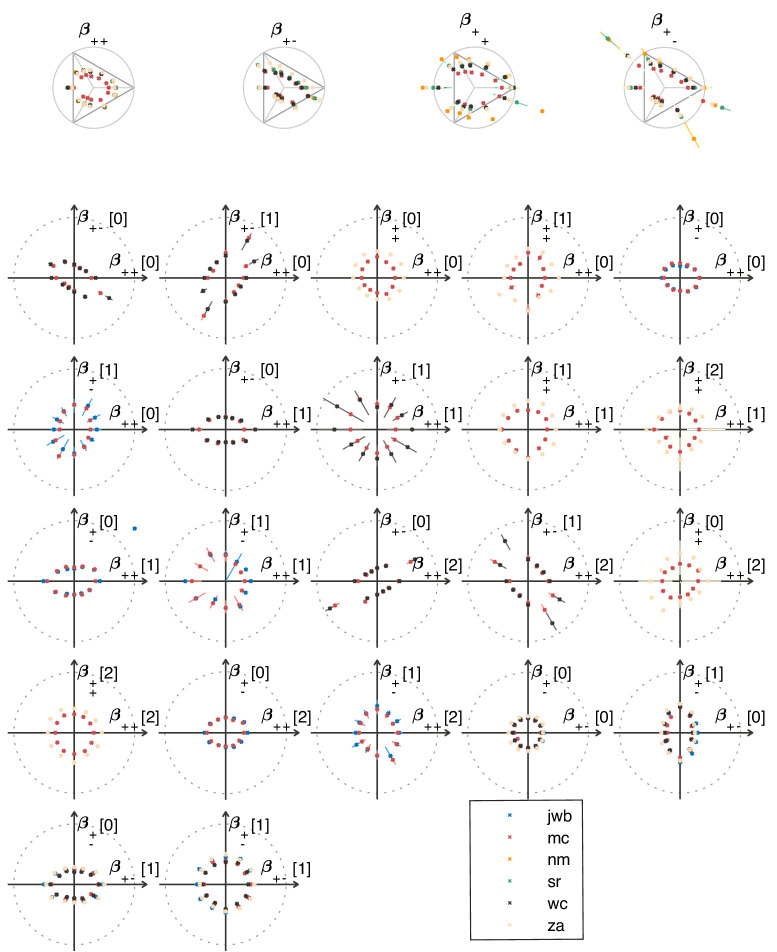
Psychophysical thresholds in the second-order planes shown for different subjects.Depending on the plane, measurements were made in 2–5 subjects in each texture direction. The notations are as in the main text (Figure 5).